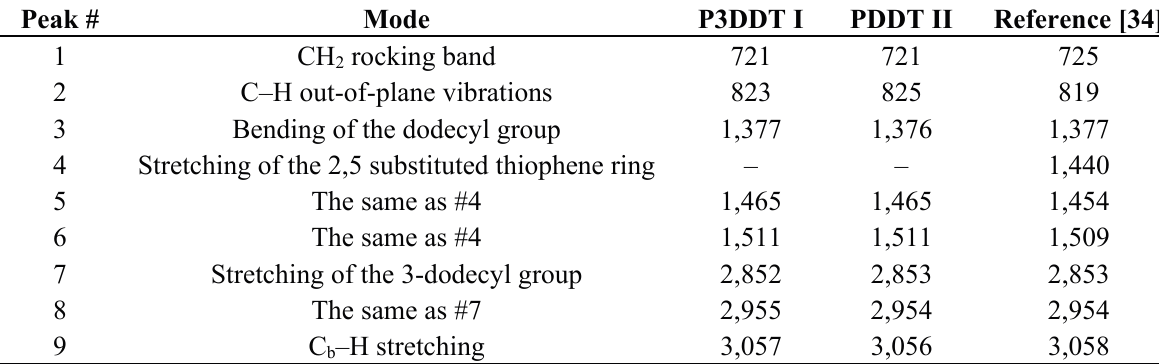
Table 3. The IR-spectra of P3DDTs compared to the values in